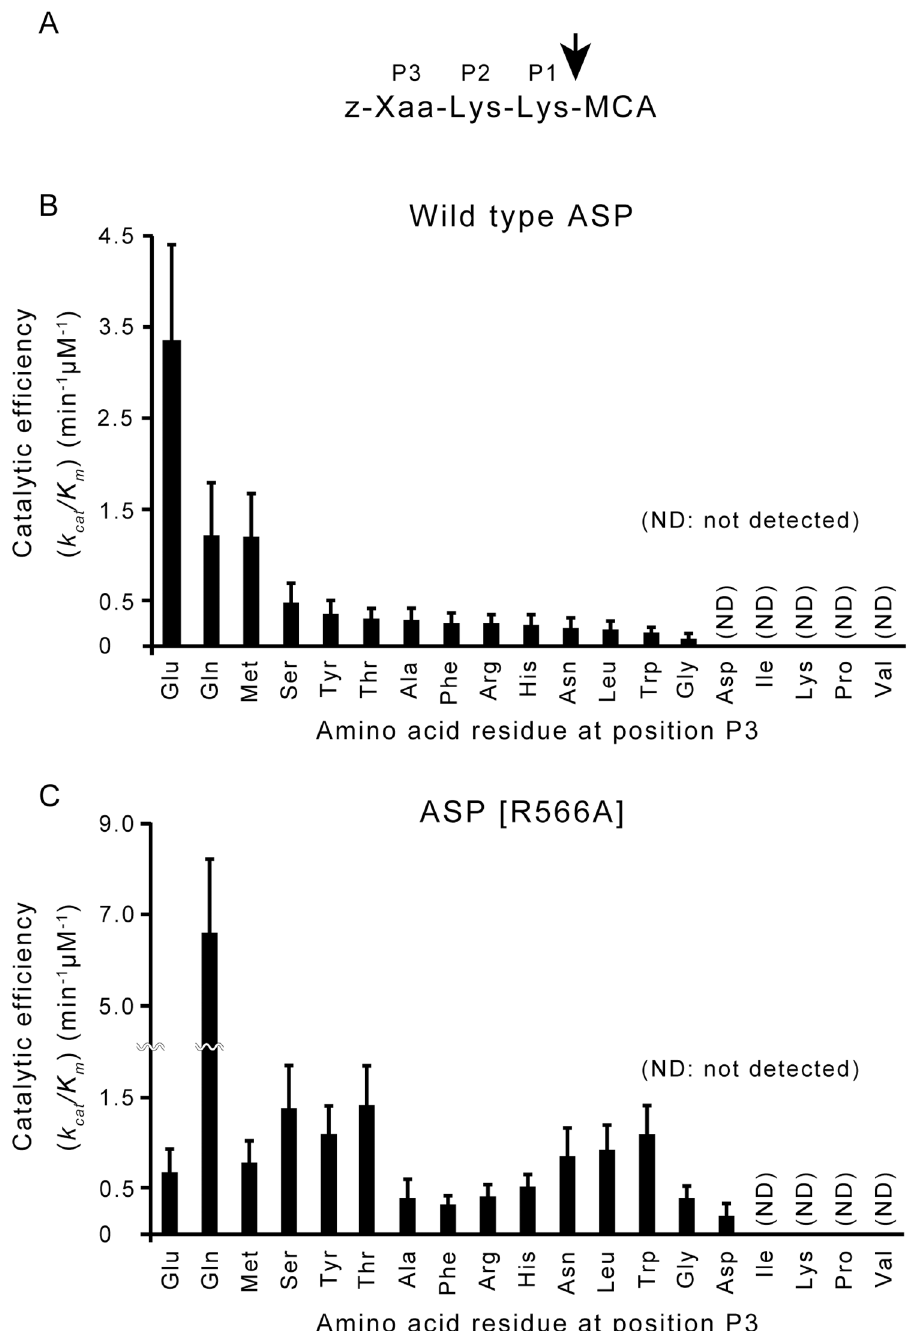
Fig 2. Cleavageof various fluorogenic peptide substrates by wild-type ASP and the mutant ASP. (A) Schematicdiagram of fluorogenicpeptidesubstrates synthesized in this study. The arrow indicatesthe positionwhere ASP cleaves [19]. The amino acid residue at P3 (shown as Xaa in the figure) is different in each substrate. Z indicatesa benzyloxycaronyl group. (B), (C) k cat / K m values calculatedfrom the reaction of wild-typeASP (B) and ASP(R566A) (C) with the various substrates. The reaction was performed as described in the Materials and Methods section, and the results obtained are shown in Table 2. The numerical values shown in Table 2 are illustrated